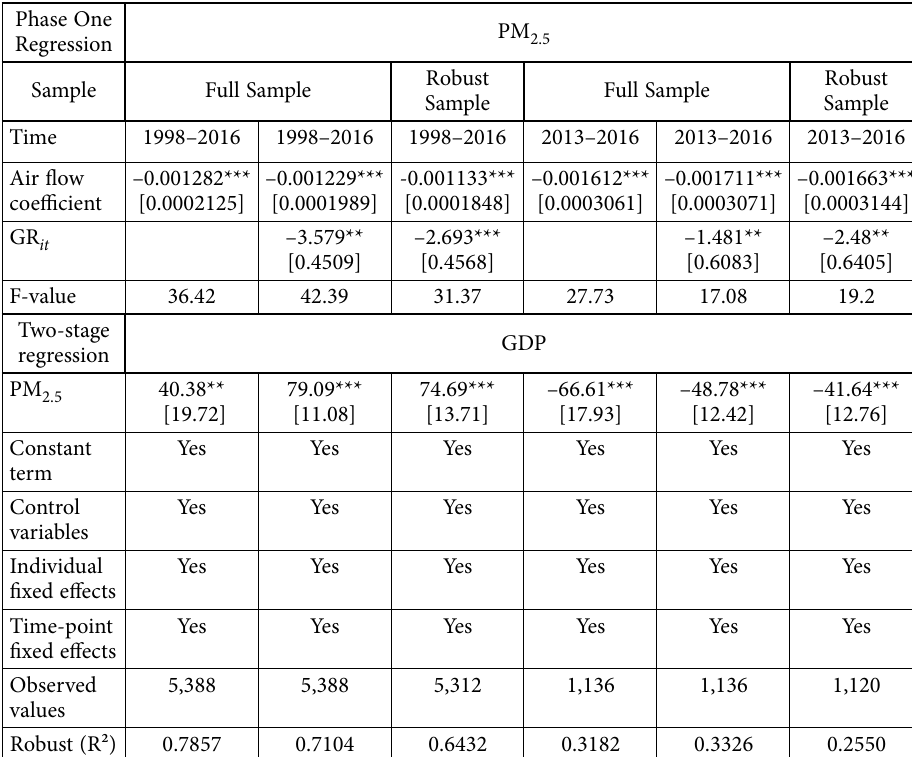
Table 5. Results of two-stage least squares (2SLS) instrumental variable method robustness tests Phase One